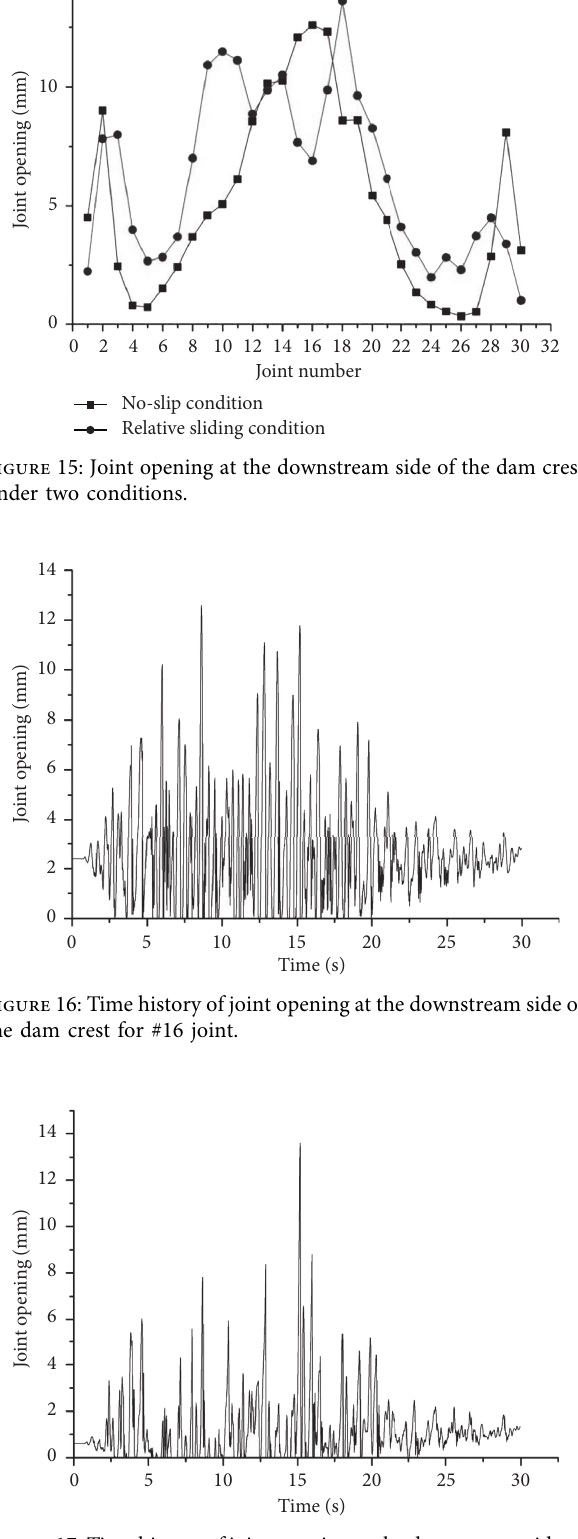
Figure 17: Time history of joint opening at the downstream side of the dam crest for #18 joint.